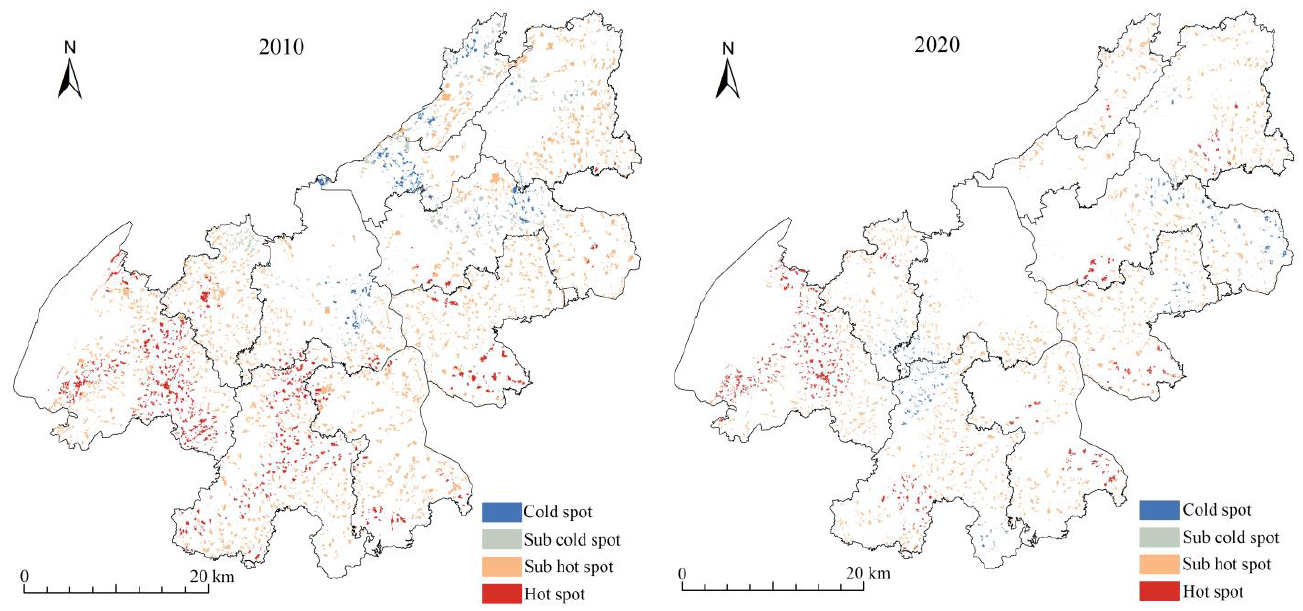
Figure 4. Hotspot agglomeration pattern of rural settlements scale from 2010 to 2020.